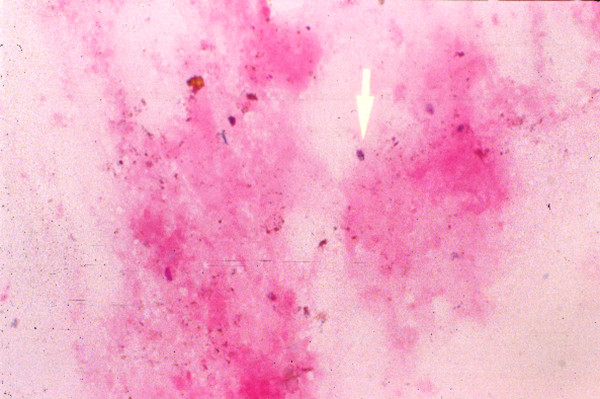
Gram stain of corneal scraping showing gram positive oval microsporidial spores (×500, 4a).